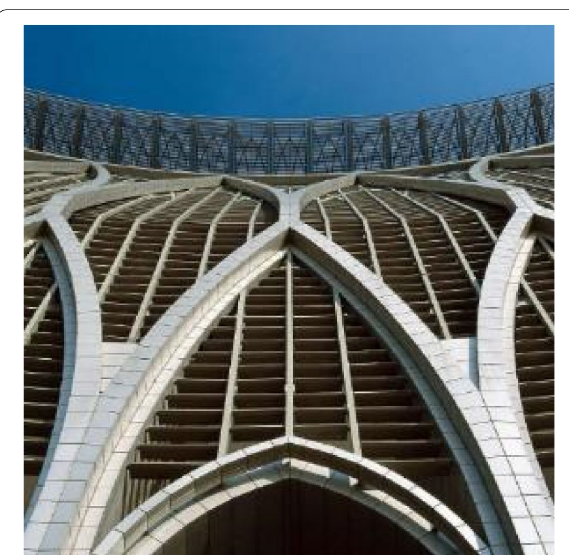
Fig. 9 Detailed geometrical arches at the main facade (GDP web,